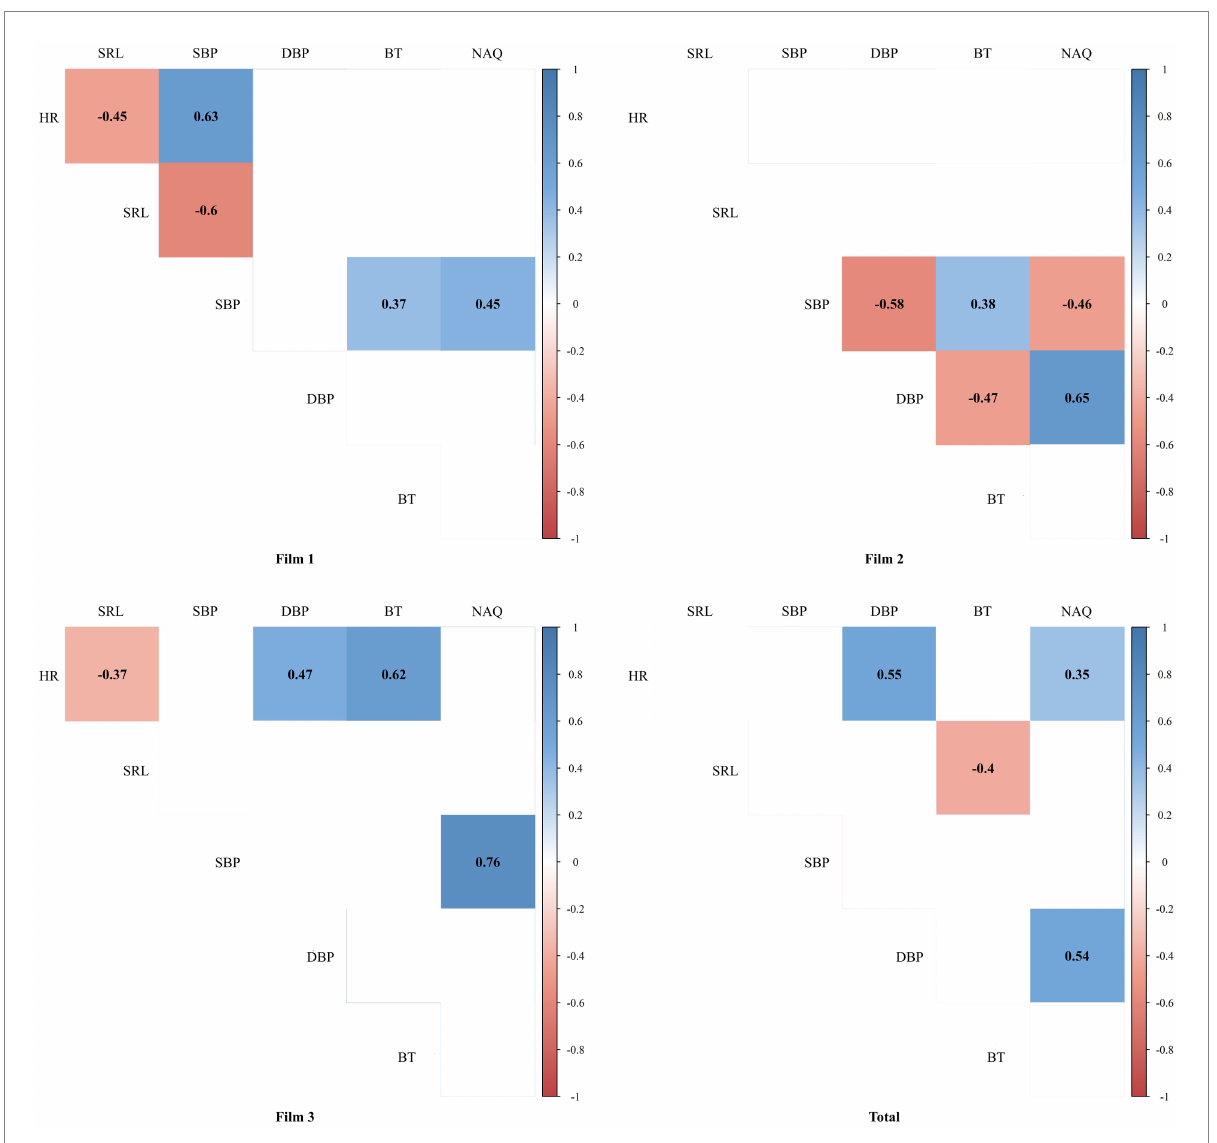
FIGURE 3 The Spearman correlation coefficient between variable